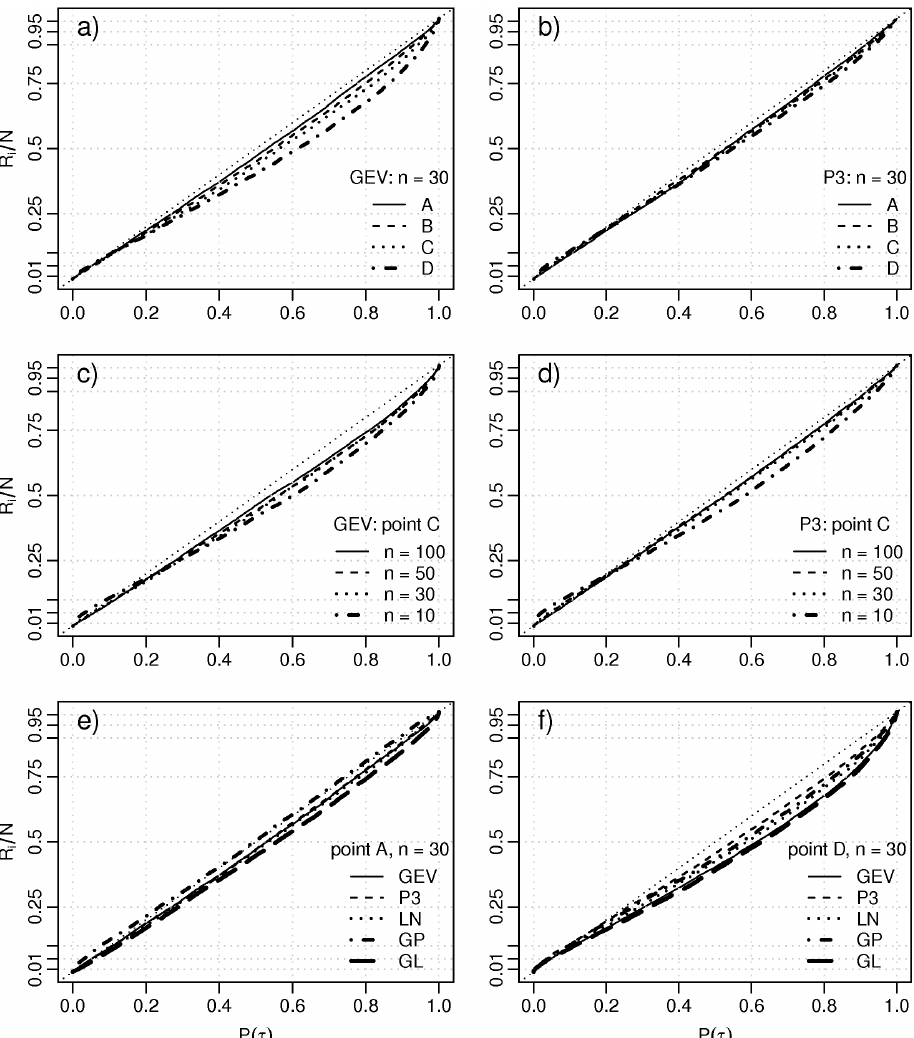
Fig. 2. Probability plot representation of P(τ) when using the log-Student t distribution of Eq. (14) to estimate the confidence intervals of τ . Different situations are considered: (a) GEV parent distributions with different asymmetry (point A, B, C, D of Fig. 1); (b) P3 parent distributions with different asymmetry; (c) GEV parent distribution and samples of different length n ; (d) P3 parent distribution and samples of different length n ; (e) different parent distributions with low asymmetry (point A); (f) different parent distributions with high asymmetry (point